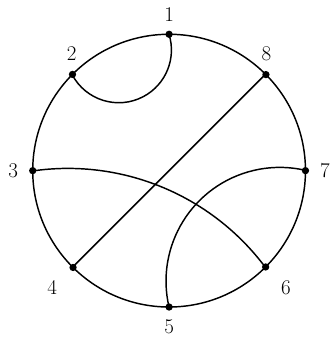
Figure 1. An example of a chord diagram for k = 8. With the numbering in the (cid:12)gure, this diagram means that I 1 = I 2 , I 3 = I 6 , I 4 = I 8 and I 5 = I 7 (and otherwise all of these are